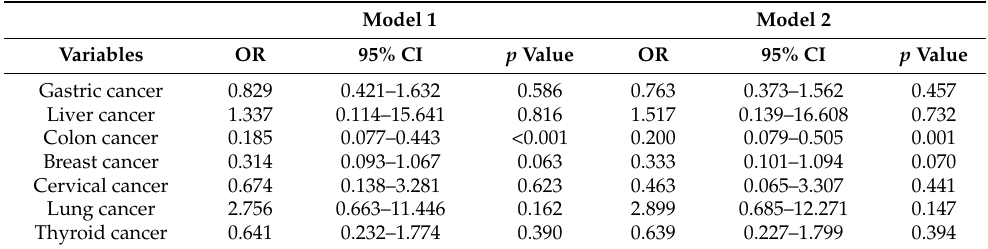
Table 3. Multivariate-adjusted ORs (95% CIs) for malignant comorbidities in spine OA compared to